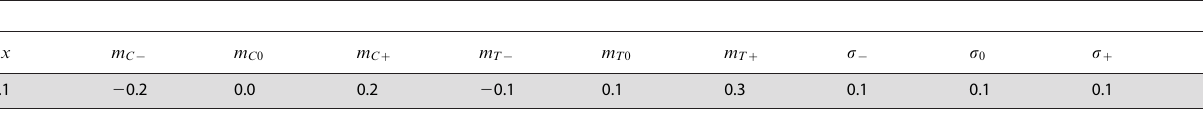
Table 3. The ground truth parameters of the underlying distributions used to generate intervention outcomes for participants in our simulated